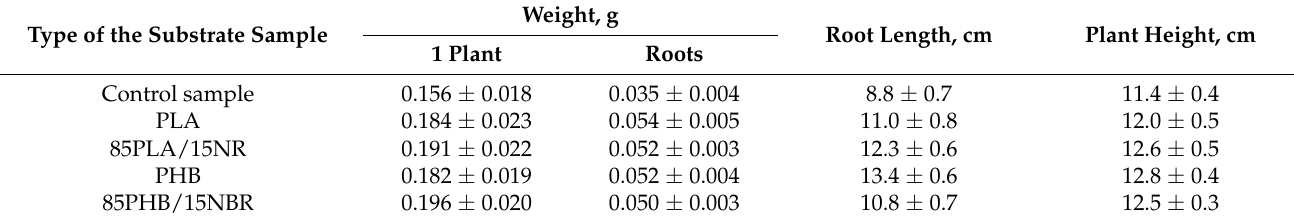
Table 1. Biometric characteristics of wheat plants of the Yubileinaya 100 variety on the 12th day of vegetation.